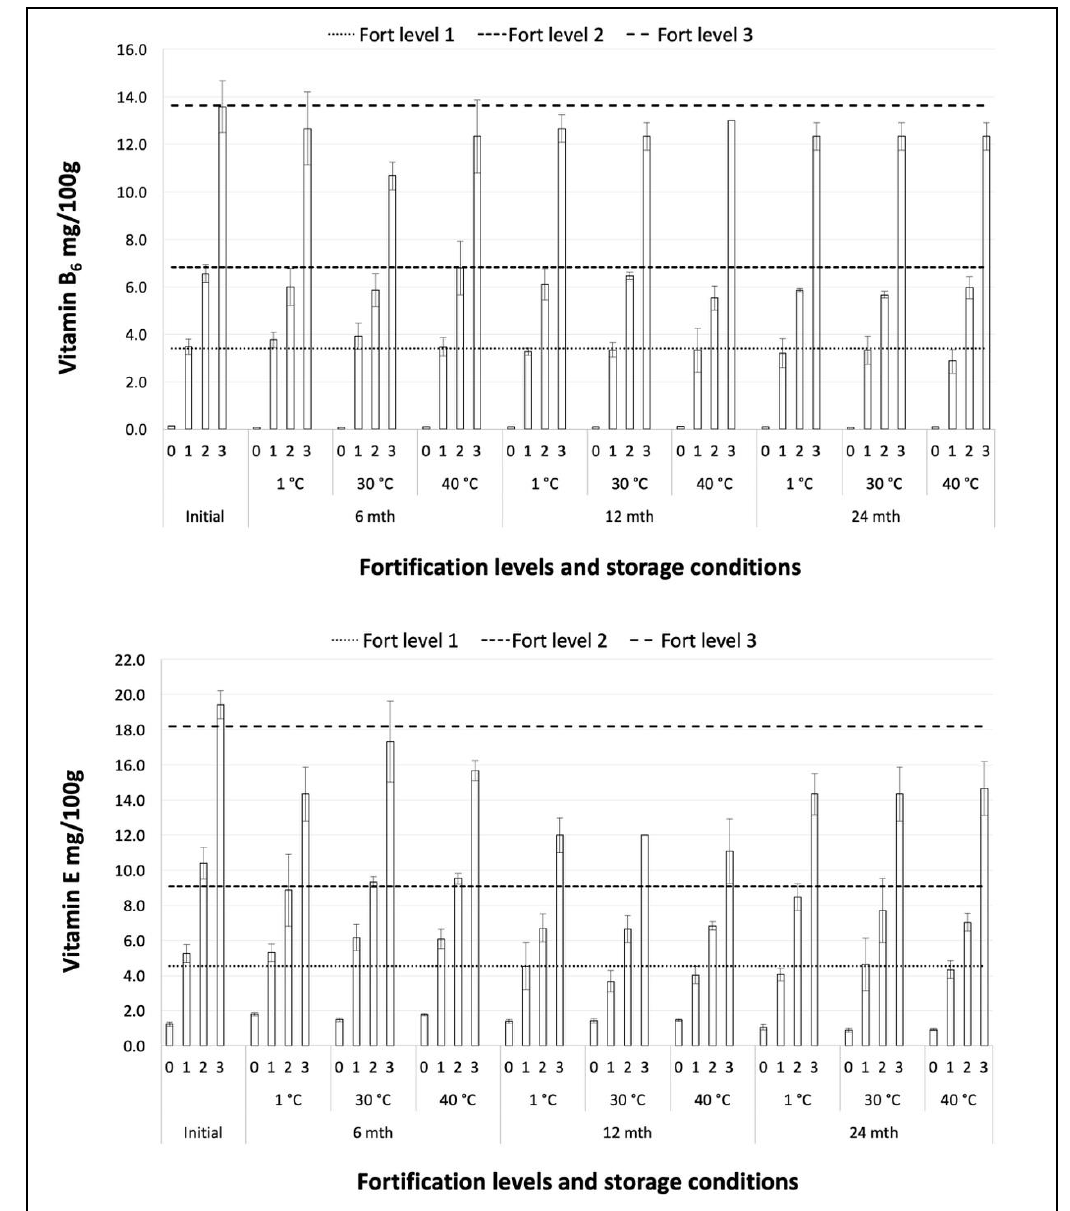
Figure 2. Vitamins B 6 and E storage stability at all levels of fortification (0, 1, 2, 3).